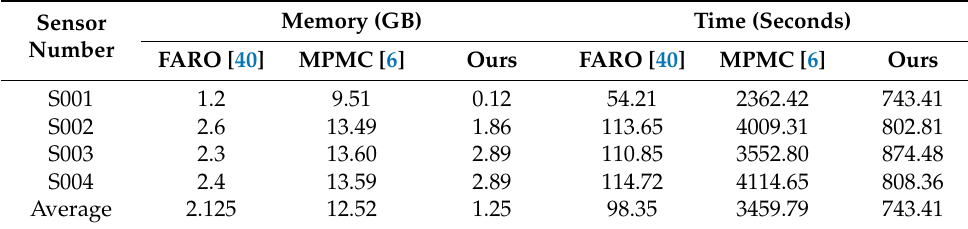
Table 8. Computational resources comparison.